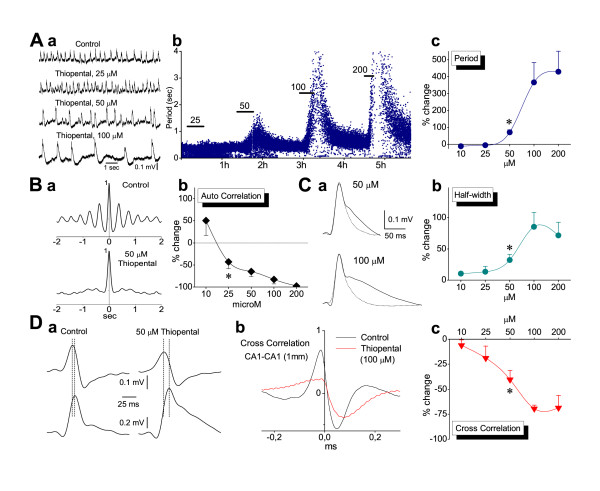
Effects of thiopental on Sharp Waves. A. Example of field recordings (a) and plot of instantaneous period (b) illustrating that thiopental induced a concentration-dependent and reversible increase in the inter-event period. Horizontal bars in "b" denote the time of application of consecutively larger drug concentrations. Relatively large data values of period during 100 and 200 μM of the drug are curtailed for reasons of clarity of lower values. Note the great value dispersion of instant period during drug application at ≥50 μM. Data in "a" and "b" were obtained from two different slices. The collective data plot (percent changes) of period is shown in (c). The asterisk here, as in the subsequent collective plots in the figure, denotes the lowest concentration with statistically significant drug action (paired t-test, P < 0.001 at 50 μM and P < 0.05 at 100–200 μM). The number of slices studied at the five concentrations, of 10, 25, 50, 100 and 200 μM, were respectively 12, 18, 22, 12 and 8. Error bars not shown were smaller than the size of the symbol. B. Example of auto-correlation before and during 50 μM thiopental (a) and collective auto-correlation plot (b) showing the disruption of rhythmicity at concentrations ≥25 μM (paired t-test, P < 0.05 at 25 μM and P < 0.01 at ≥50 μM). Numbers of slices studied at the five concentrations were 5, 6, 12, 8 and 4. C. Example of thiopental-induced prolongation of SPWs (a) at two different concentrations. Averages of low-pass filtered sweeps taken from a two minute epoch are shown. Dotted traces are control sweeps. The corresponding collective plot (b) shows that significant prolongation of single SPWs occurred at drug concentrations ≥50 μM (paired t-test, P < 0.01). D. Effect of thiopental on SPWs' synchronization along the CA1 region. Single SPWs simultaneously recorded from two locations along the CA1 st. pyramidale, measuring 1 mm, are shown in "a", before (traces on the left) and during application of 50 μM thiopental (traces on the right). Sweeps were low-pass filtered in order to make feasible the time-discrimination of their peaks. Note the increased phase-lag (marked by dotted lines) during drug application (9.25 ms) compared with control condition (3.8 ms). The cross-correlation plot from another slice (b) illustrates the large decrease of function value during drug application at 100 μM. The collective plot (c) shows that significant suppression of synchrony started at 25 μM and reached a plateau at 100 μM (P < 0.05 at 50 μM and P < 0.01 at ≥50 μM). Numbers of slices studied at the five concentrations were 3, 5, 5, 4 and 4.